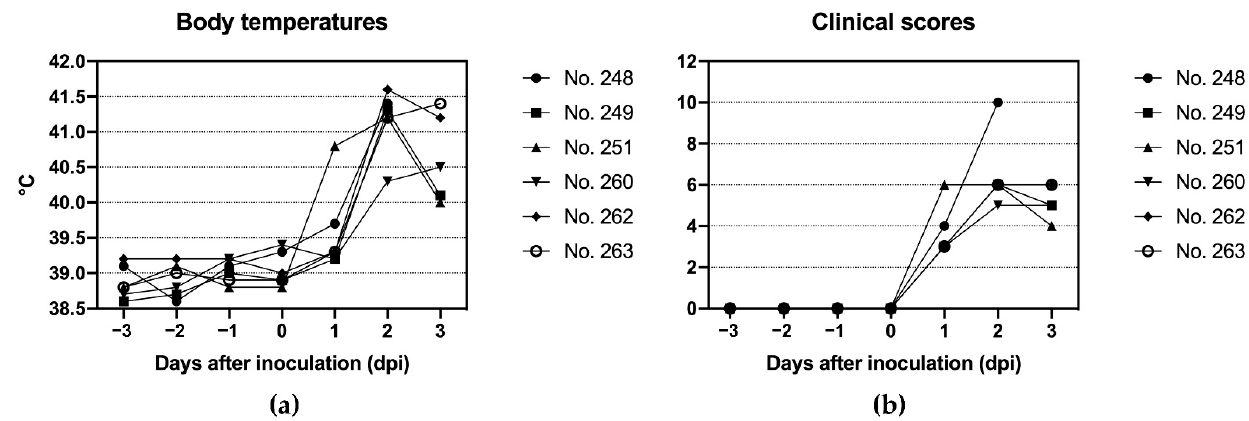
Figure 2. Clinical findings in the first animal experiment after injection of naked FMDV RNA into the tongue: ( a ) rectal body temperatures; ( b ) clinical scores. See Tables S1 and S2 in the Supplemental Material for the raw data summarized in this